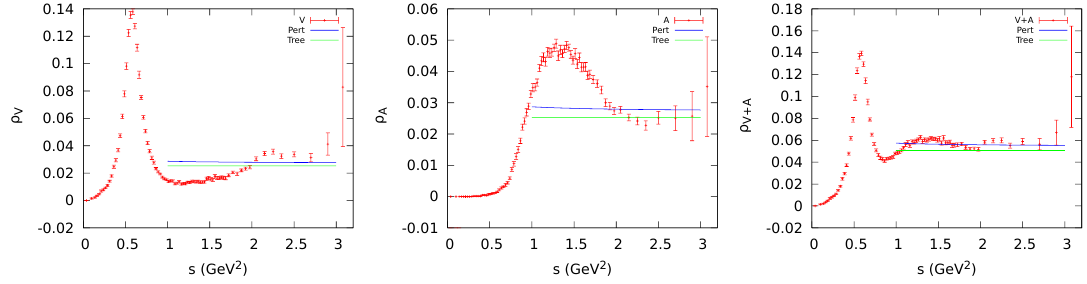
Figure 1 . Updated ALEPH spectral functions for the V , A and V + A channels [39]. The pion pole is not